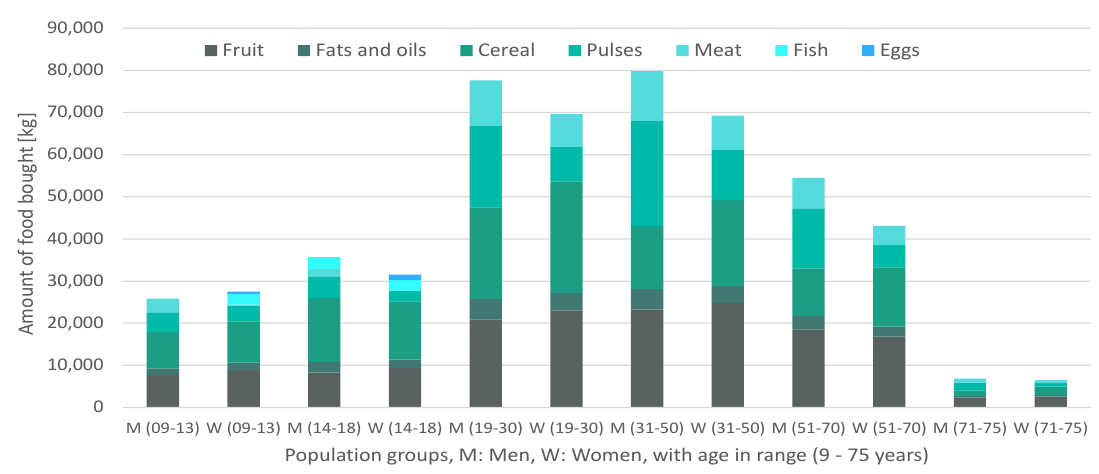
Figure 5. Optimal amounts of food purchased without donations.